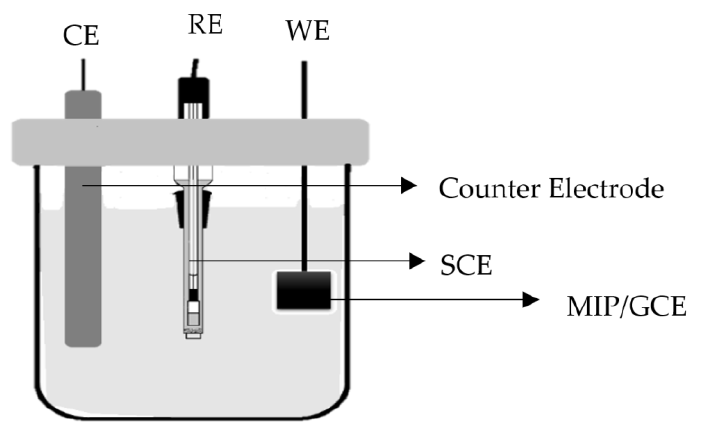
Figure 2. Electrochemical cell setup with three types of electrodes (i) Counter Electrode (platinum wire), (ii) Reference Electrode (SCE), and (iii) Working Electrode (MIP/GCE).